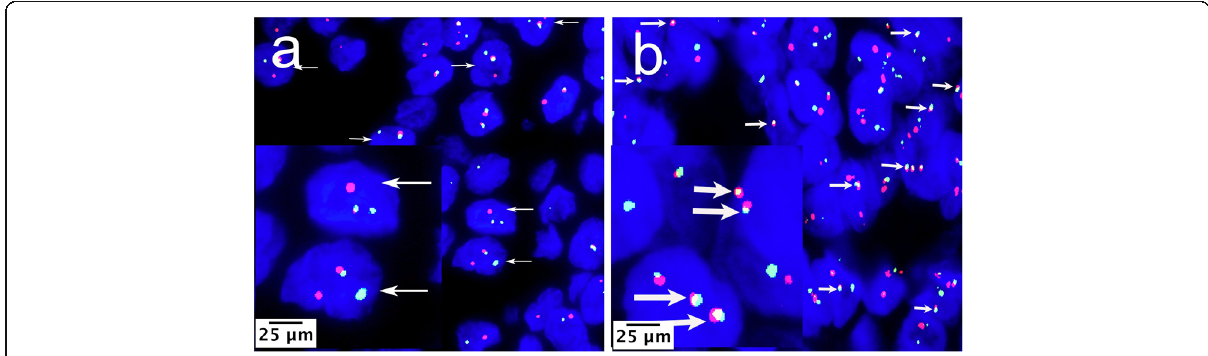
Fig. 6 FISH for CCC. ( a ) FISH with EWSR1 break-apart probe. The break-apart probe shows one separate red and green signal per cell (arrows) was considered positive for EWSR1 rearrangement; the fused red-green (yellow) signal was considered normal (Case 1, FISH× 1000). ( b ) FISH with EWSR1-ATF1 fusion probe. Showing at least one red-green (yellow) fusion signal per cell (arrows) was considered as EWSR1-ATF1 fusion positive (Case 1,